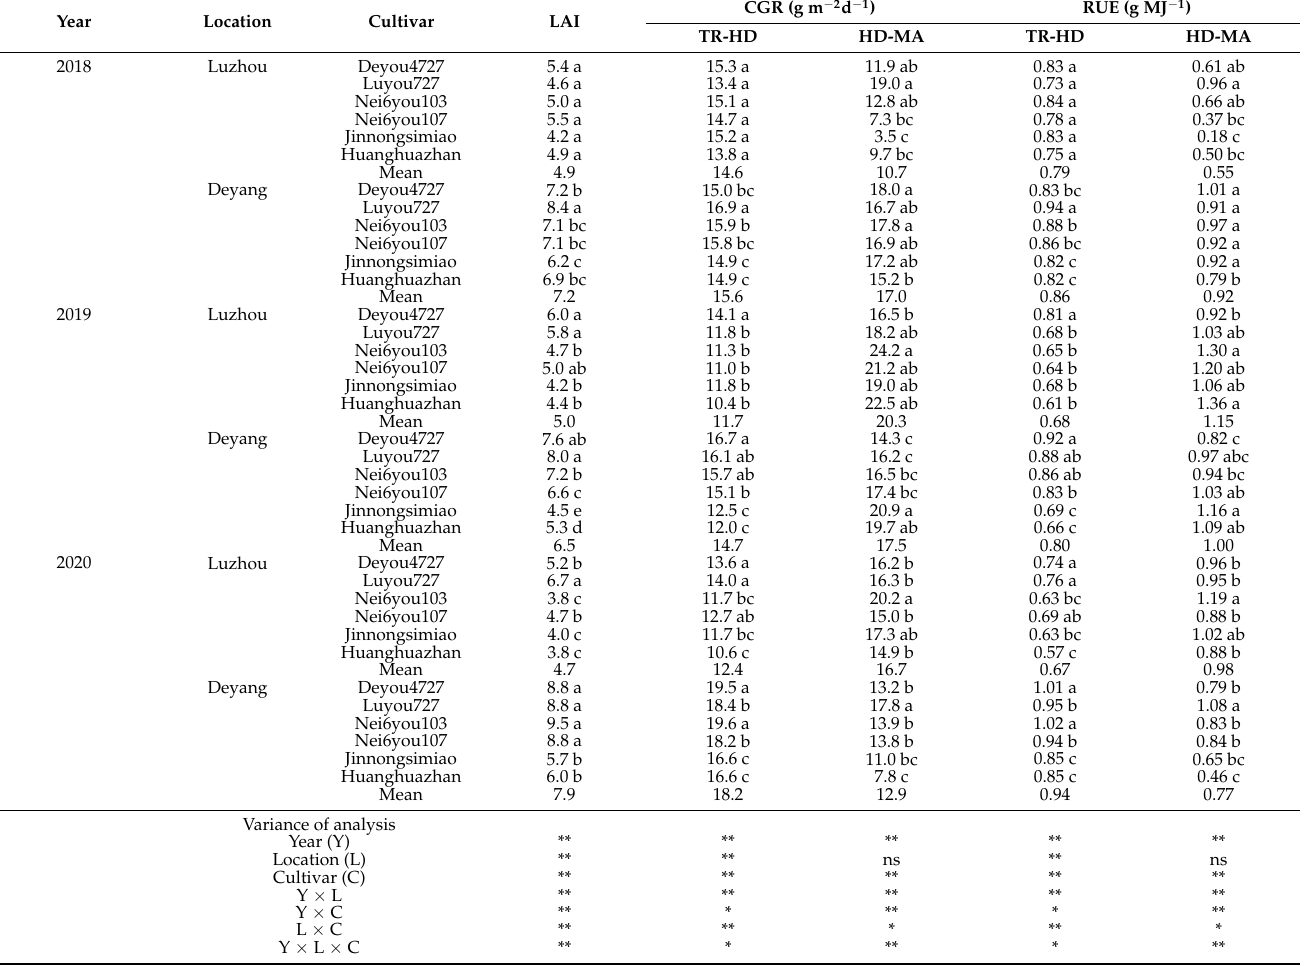
Figure 4. Relationships between biomass production and maximum temperature ( a ), minimum tem- perature ( b ), and solar radiation ( c ) during the pre-heading periods and between biomass produc- tion and maximum temperature ( d ), minimum temperature ( e ), and solar radiation ( f ) during the post-heading periods for six rice cultivars over three years. ‘* ‘and ‘**’ denote significant relation- ships at the 0.05 and 0.01 probability levels, respectively.